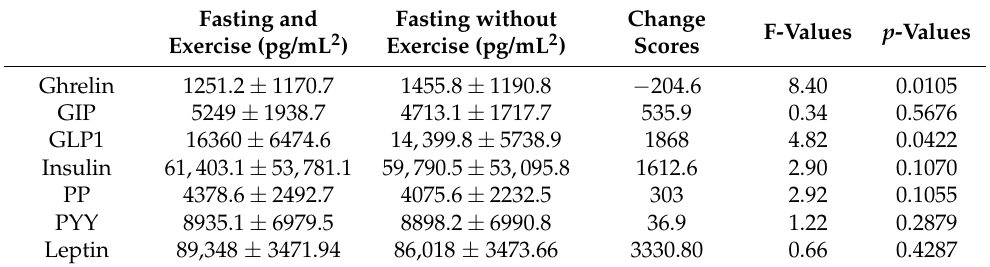
Table 3. Differences in area under the curve for fasting with and without exercise over 36 h. Fasting and Fasting without Change F-Values p Exercise (pg/mL 2 ) Exercise (pg/mL 2 ) Scores